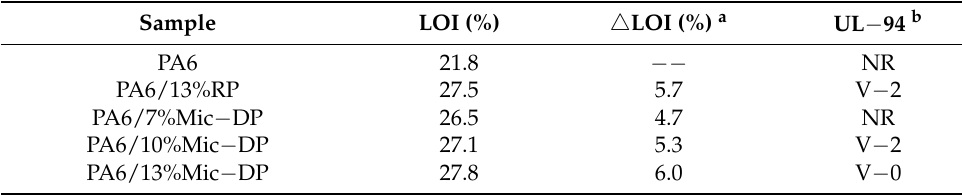
Table 4. LOI value and UL 94 data of PA6 samples.